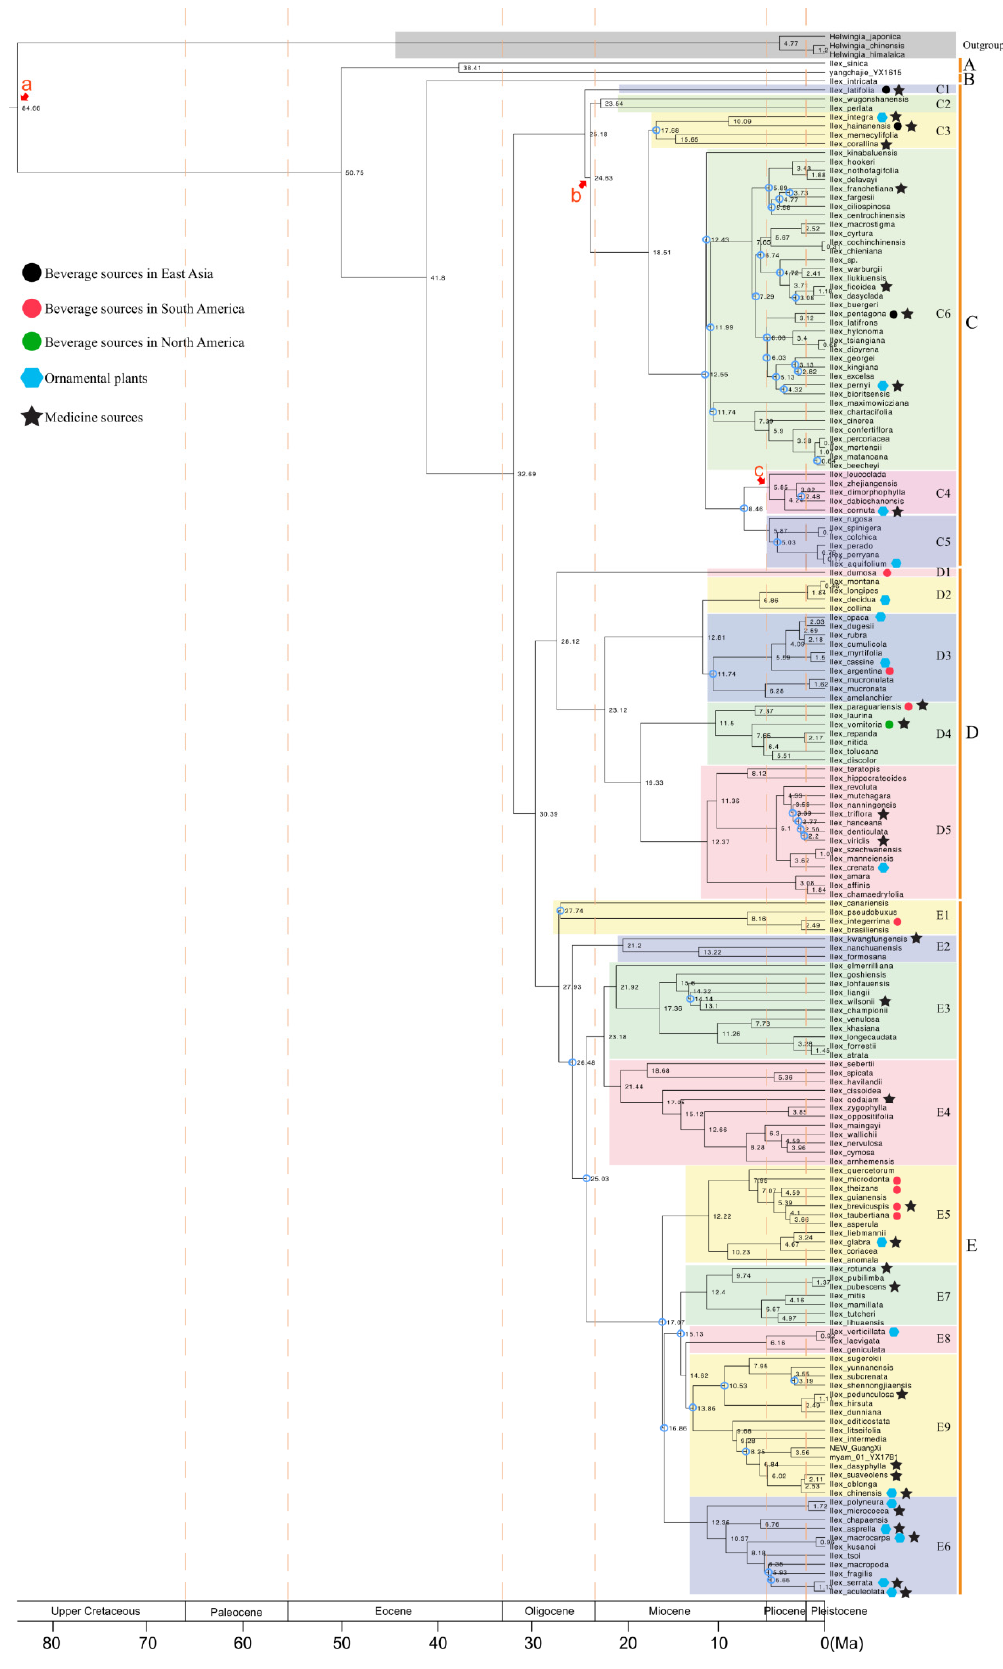
Figure 2. Ilex species with different uses mapped onto the phylogeny, based on Figure 1 in Yao et al.